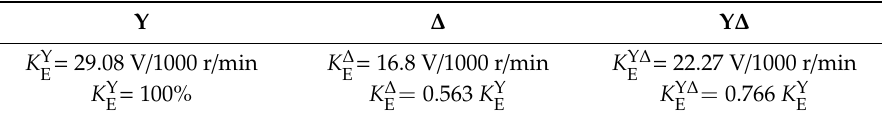
Table 2. BEMF constants for the analysed configurations.